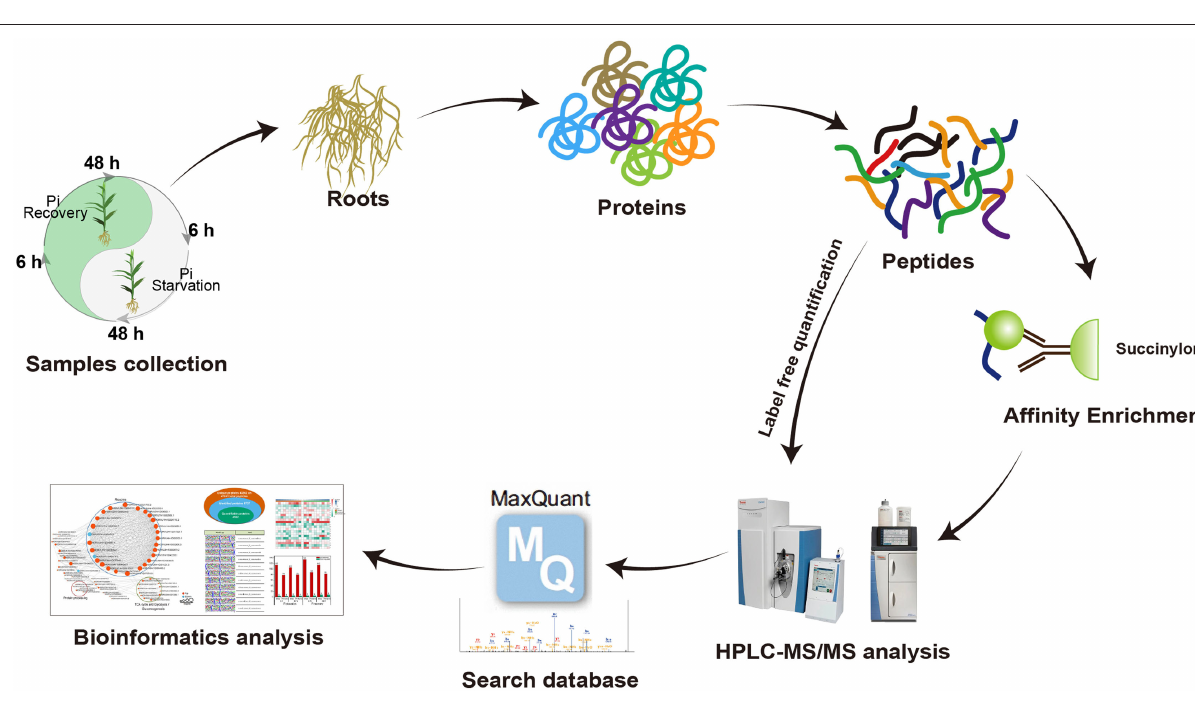
difffrentially abundant succinylated proteins (DFASPs) and sites within each group. Compared with the control, there were 81 DFASPs from 119 succinylated sites during Pi starvation (6 h), 83 DFASPs from 110 succinylated sites during Pi starvation (48 h), 93 DFASPs from 139 succinylated sites during Pi recovery (6 h), 91 DFASPs from 123 succinylated sites during Pi